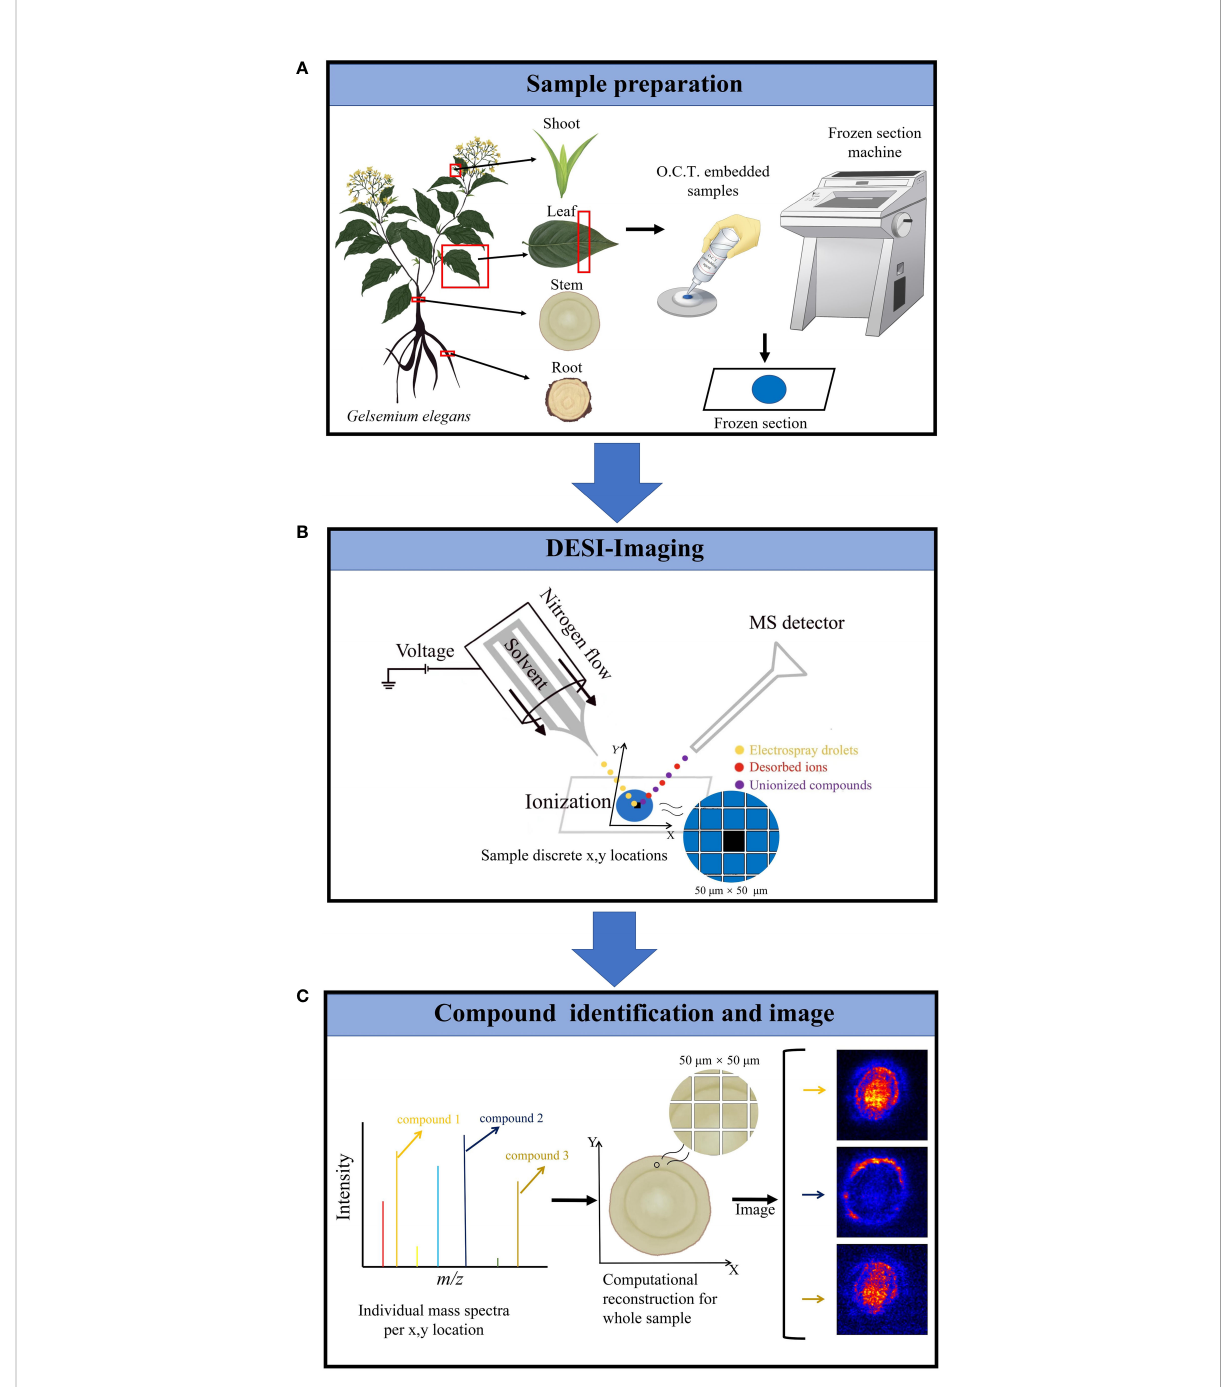
FIGURE 2 DESI-MS imaging experiment work fl ow. (A) The plant sample preparation for DESI-MSI. Frozen sections of four organ/tissue sections (roots, stems, leaves, and shoots) of G elegans were prepared. O.C.T. was used as the embedded agent. (B) The frozen sections were placed on the mobile platform of DESI-MSI. The DESI sprayer consists of a solvent emitter surrounded by a second capillary that delivers a nebulizing gas fl ow. Methanol in water (98:2, v/v) was used as the solvent. The DESI directs charged droplets to 50 m m × 50 m m lattice with a certain coordinate (X, Y) via a spray capillary, the ESI (electrospray ionization) stream impacts the extracting and ionizing analytes. Finally, the mixed droplets were ejected into the mass spectrometer. Imaging area was determined according to the lattice dimensions. (C) Target molecules identi fi cation and imaging. The resulting mass spectra for each coordinate (X, Y) was computationally reconstructed to form a complete dataset. The resultant reconstructed ion image represents the spatial distribution of the corresponding molecules. The acquisition setup, processing, and visualization of data were performed using HDI